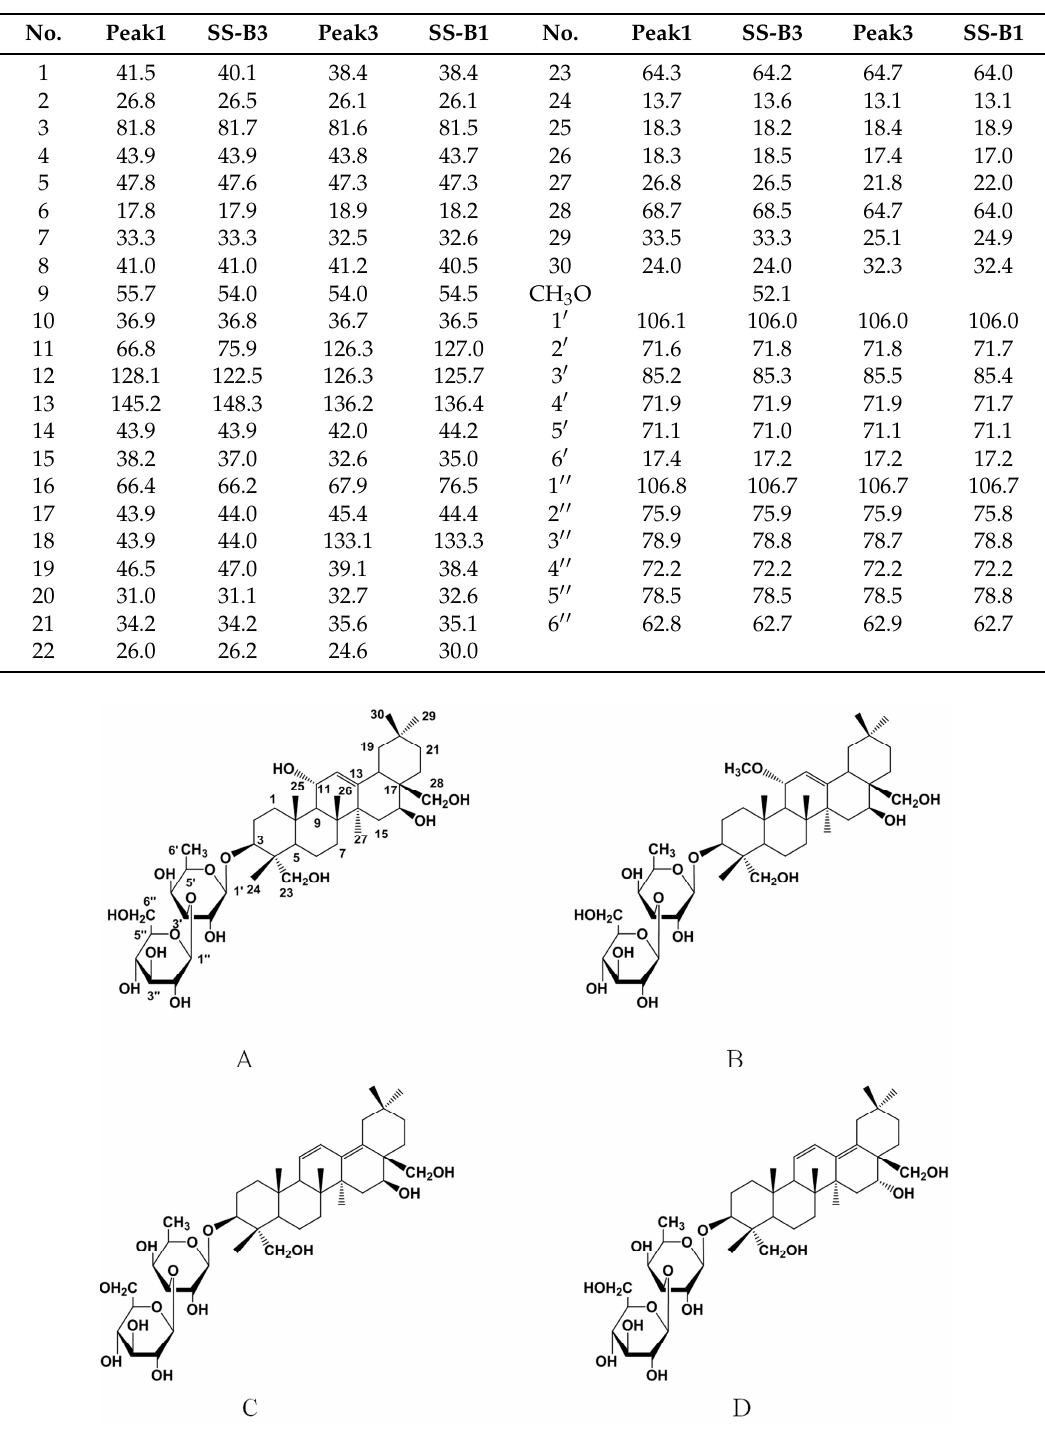
Table 2. 13 C-NMR spectral data comparison of Peak 1 with SS-B3 and Peak 3 with SS-B1 (C 5 D 5 N, δ ppm).